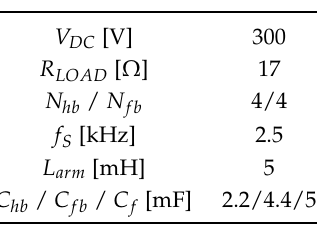
Table 2. Converter